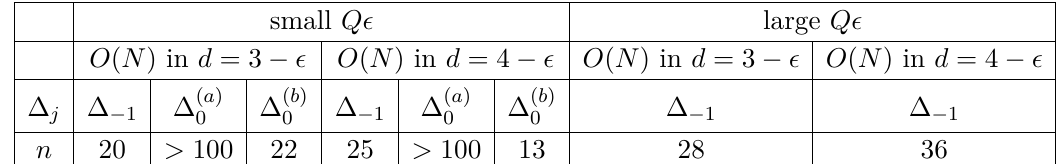
)) of the leading singularity in the coefficient functions 0